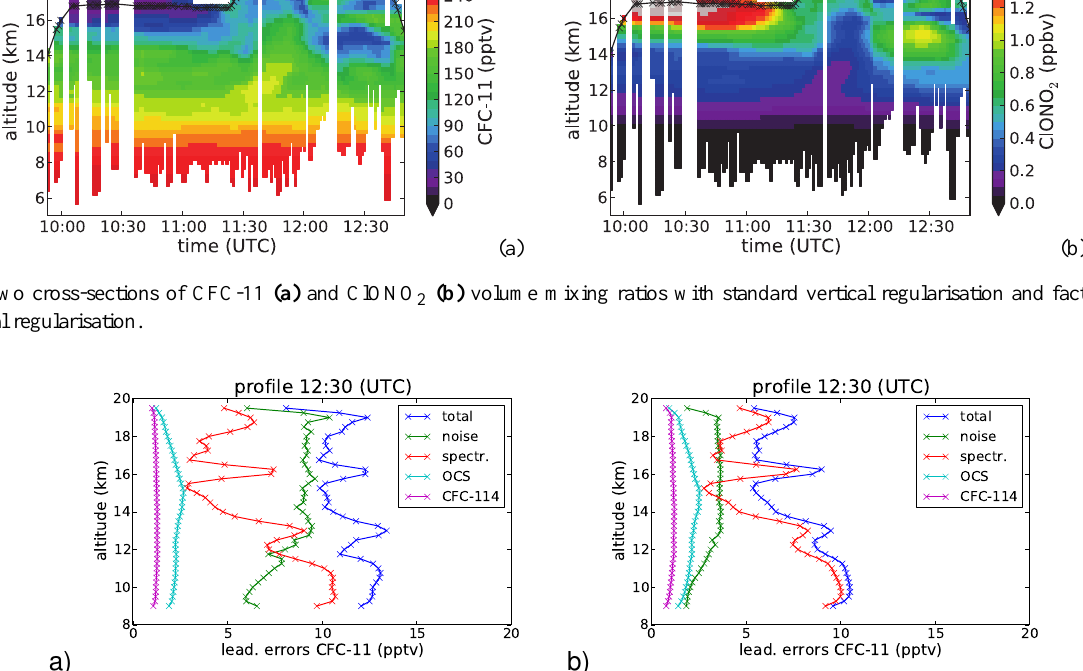
Fig. 6. Leading errors in CFC-11 volume mixing ratio for a representative profile (12:30UTC) and the baseline regularisation in panel (a) and a factor-2000 horizontal regularisation in panel (b) . “spectr.” notes the error induced by uncertainties in CFC-11 spectral data. “OCS” and “CFC-114” are the systematic errors induced by the uncertainty in volume mixing ratios of these background gases. the vertical one (factor-2000). This result is devoid of